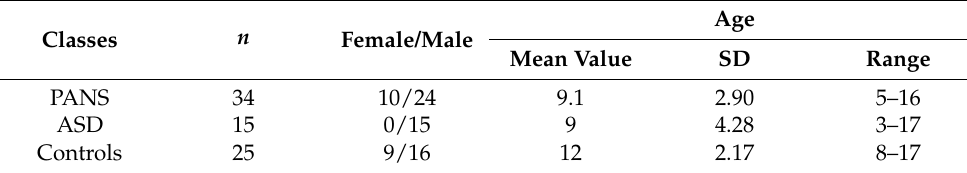
Table 1. Demographic data of the enrolled